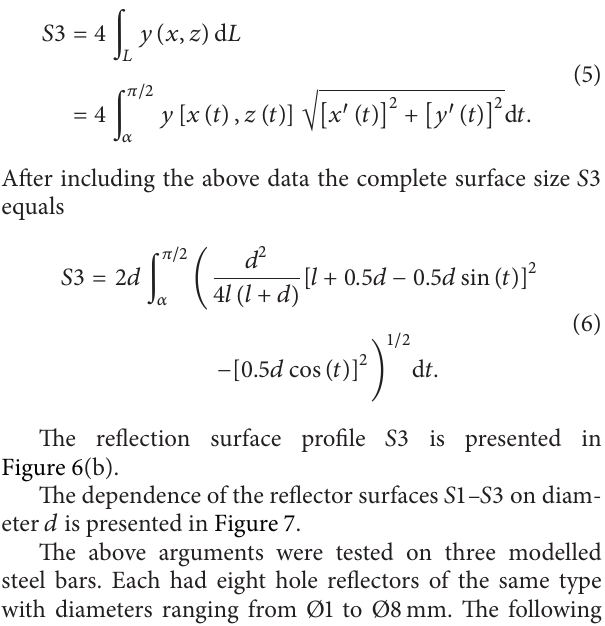
Figure 6: Integral limits for the quarter of the cylindrical surface 𝑆3 surrounded by a red line (a) and the surface profile 𝑆3 surrounded by a red line in the upper part of the cylinder (b).